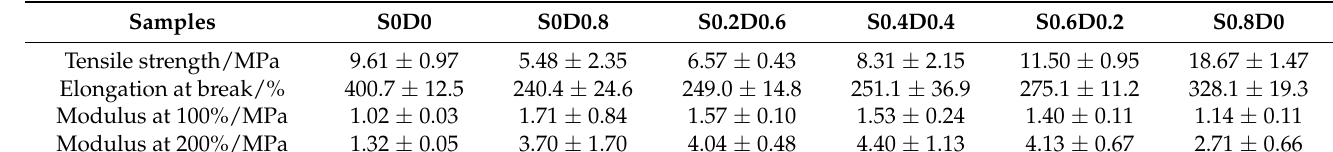
Figure 3. The stress-strain curves of PNB at 24 °C.